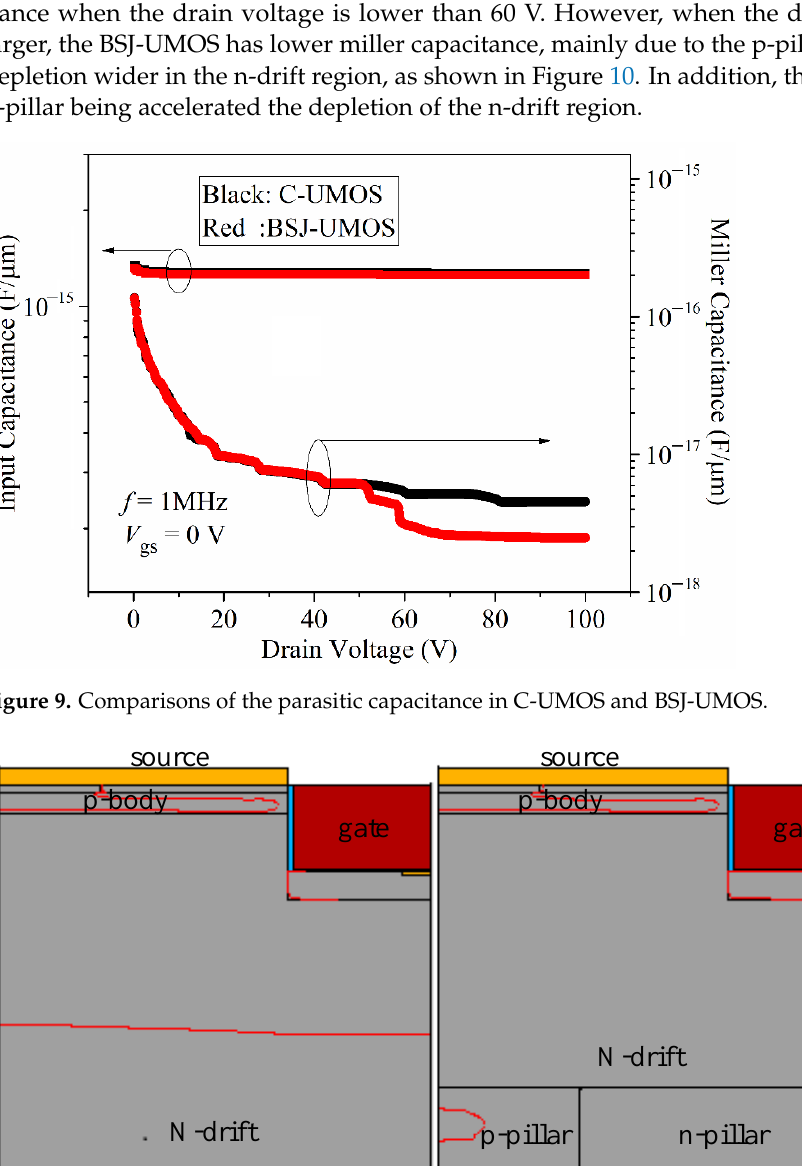
7 of 13 Figure 8. Electric field distributions of BSJ-UMOS and C- UMOS along CC’ ( y = 3.4  m), DD’ ( y = 6.0